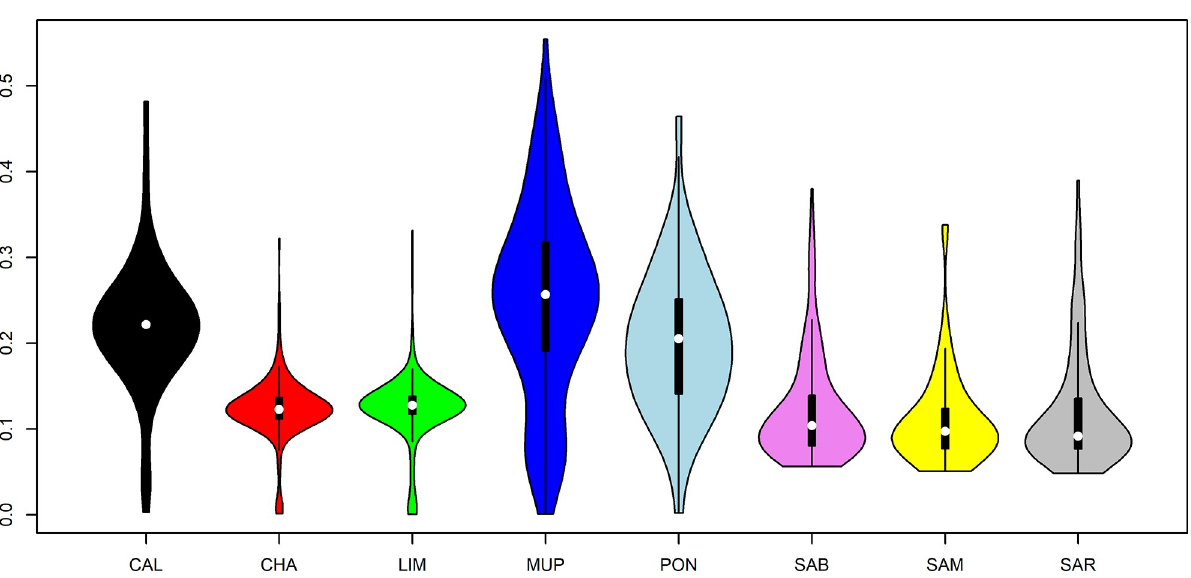
Fig 6. Descriptive statistics of FROH distribution for the eight breeds. CAL = Calvana; CHA = Charolais; LIM = Limousine; MUP = Mucca Pisana; PON = Pontremolese; SAB = Sardo Bruna; SAM = Sardo Modicana; SAR = Sarda. https://doi.org/10.1371/journal.pone.0248087.g006 to cell survival after damage or stress ( TIMELESS ; Timeless Circadian Regulator), transport and/ or esterification of cholesterol ( APOF ; Apolipoprotein F), growth regulation, development and differentiation ( SLC39A5 —Solute Carrier Family 39 Member 5, PA2G4 —Proliferation-Associated 2G4, CD63 —CD63 Molecule) and olfactory receptors ( OR10P1 , OR6C4 , OR2AP1 , OR6C2 , OR6C68 ). For LIM, the most interesting detected genes were located on BTA2: CYP27C1 (encod- ing a member of the cytochrome P450 superfamily), MSTN (Myostatin) and genes encoding col- lagen chains ( COL5A2 —Collagen Type V Alpha 2 Chain, COL3A1 —Collagen Type III Alpha 1 Chain). MUP and PON shared CACNG2 (Calcium Voltage-Gated Channel Auxiliary Subunit Gamma 2), which is on BTA5; It is a gene involved in synaptic plasticity, learning and memory. Homozygosity by descent (HBD) segments and global inbreeding The percentage of non-HBD segments was higher in SAB (42.7%), followed by SAM, SAR and MUP (~ 39%), while CHA, LIM and PON showed values around 32.5%. The HBD segments Table 3. Mean and standard deviation (SD) of F ROH per class of length for each breed. < 2